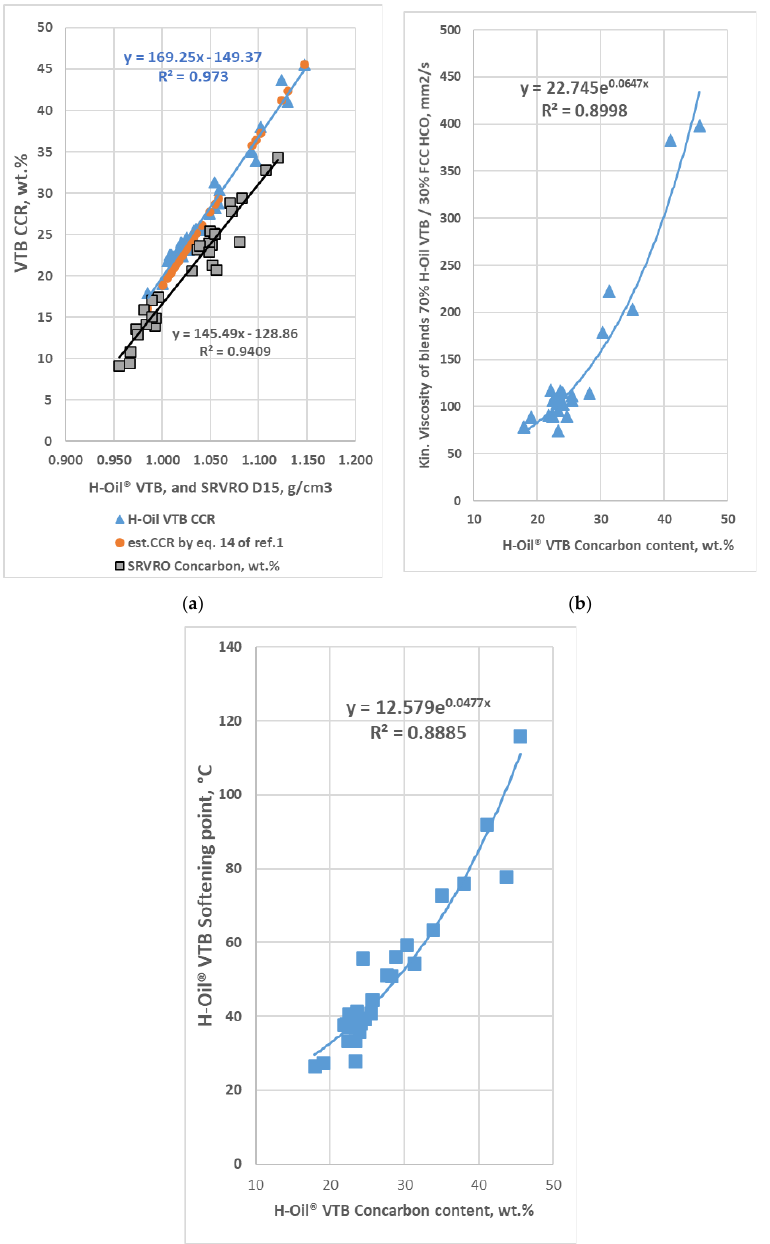
Figure 5. Dependence of density ( a ), viscosity ( b ), and softening point ( c ) of H-Oil ® VTB on Concarbon